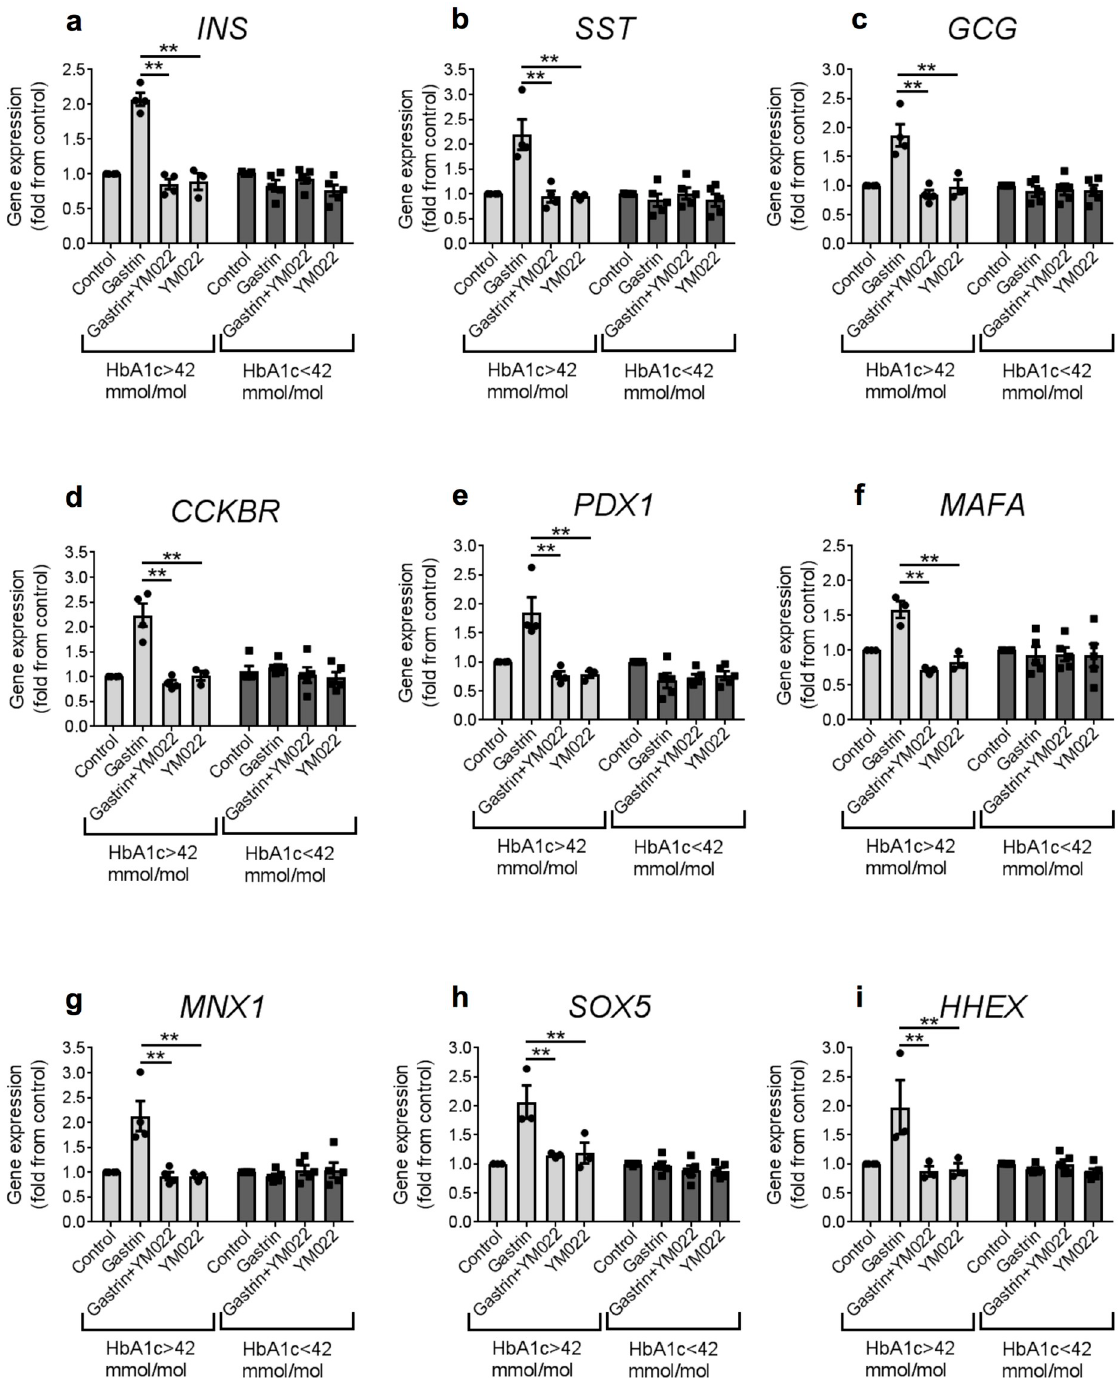
Fig 3. The effects of gastrin on human islets from donors with higher HbA 1c are mediated by the gastrin receptor CCKBR. a-i. Isolated human islets were incubated with 100 nmol/l gastrin and/or a CCKBR antagonist YM022, and cultured for 48 h before qRT-PCR analysis. Data are mean ± SEM from a total of 5 and 3–4 independent donors of lower and higher HbA 1c , respectively. A 2-way ANOVA followed by a Tukey multiple comparison posttest statistical analysis was performed to determine significance. � p < 0.05, �� p < 0.005.